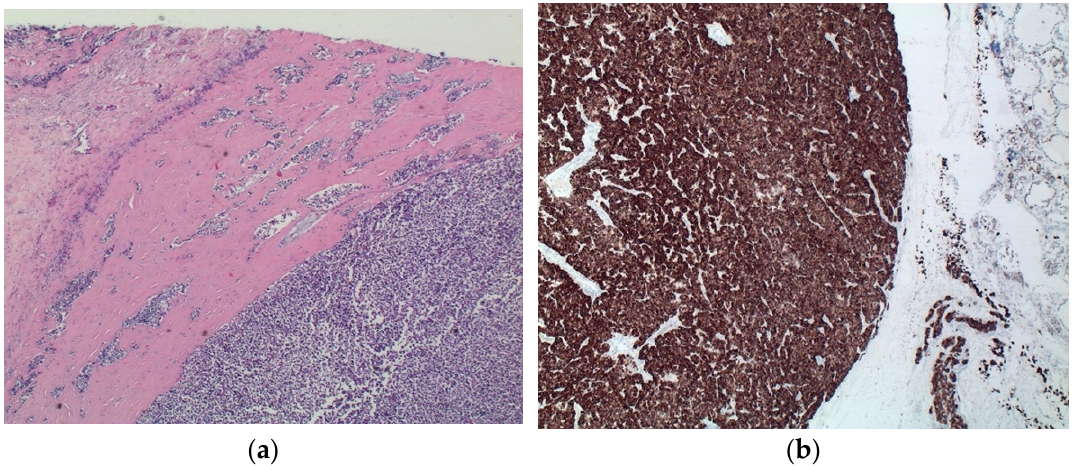
Figure 4. Parathyroid. ( a ) H&E staining—magnification 120×. The nodule tightly stuck to the thyroid disclosed a uniform patternless solid proliferation of round cells with a scant amount of cytoplasm, seldom arranged in a lobular pattern, surrounded by a dense fibrous capsule that adheres to adjacent tissues. Nuclei are irregular and hyperchromic. There is evidence of capsular and vascular invasion. ( b ) IHC chromogranin—magnification 120×. Cells are widely positive compared to negative thyroid tissue (right side).